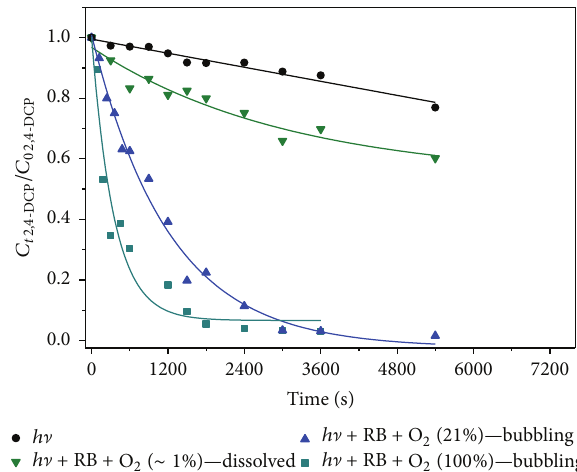
Figure 2: The dependence of 2,4-DCP relative concentrations decay on the concentrations of oxygen in the system ( 𝐶 02,4